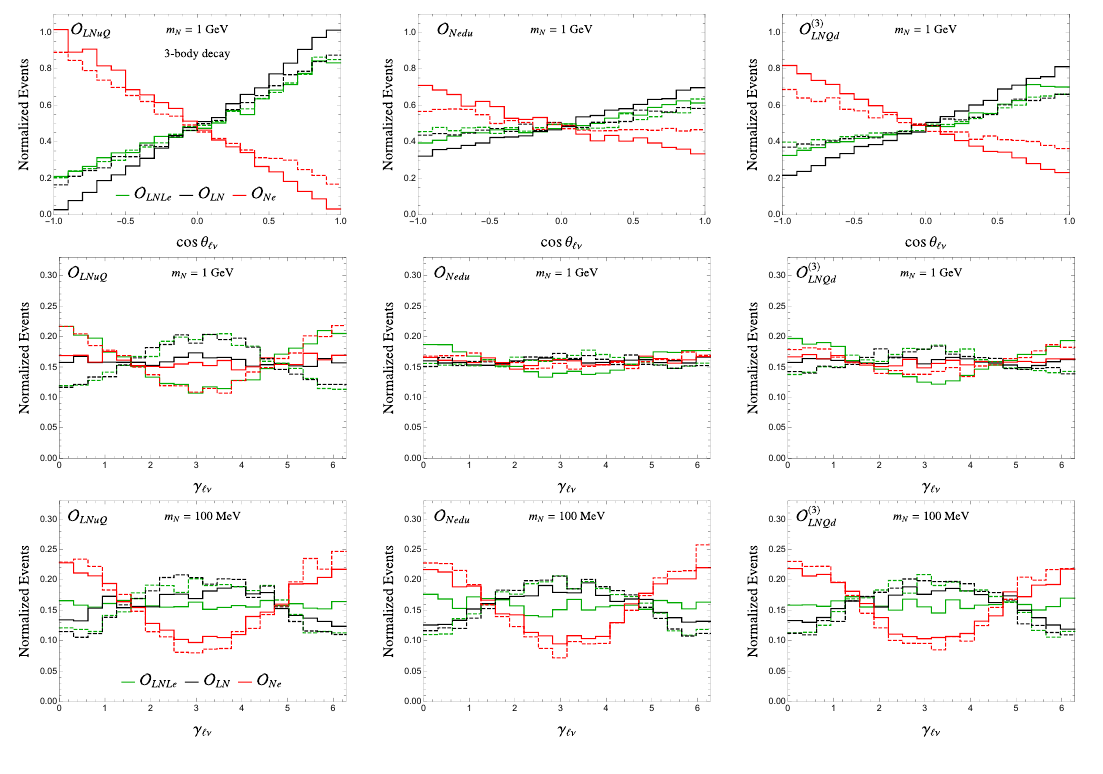
Figure 12 . Same as figure 11, except for angular observables associated with ‘ν .